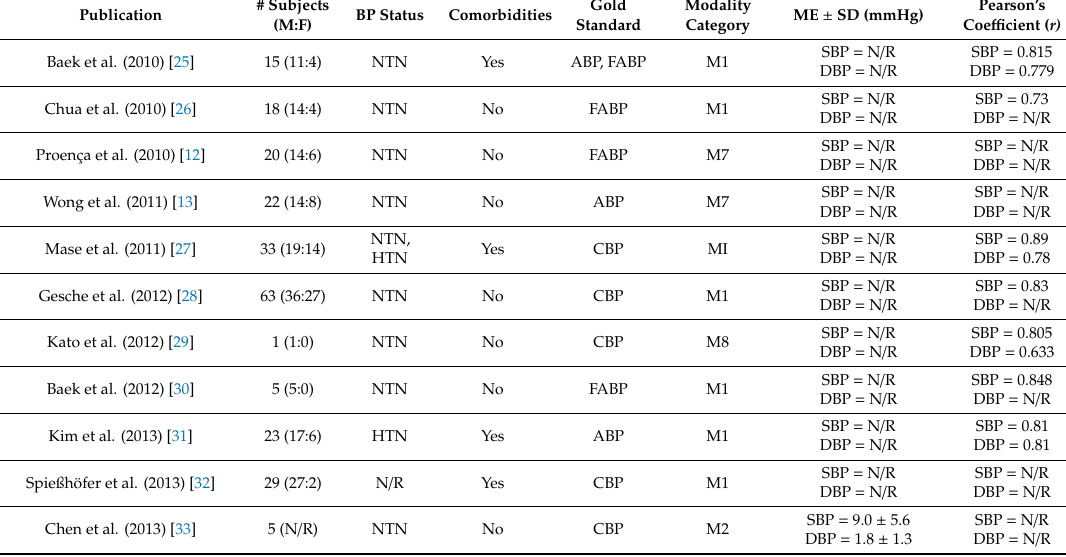
Table1. Summaryfindingsofthe73papersincludedinthisreview. Studiesthatreportedvaluesformultiple study populations have been averaged for simplicity as per our methods and represented in italic. Studies that achieved mean difference and standard deviation for both SBP and DBP within the ANSI / AAMI / ISO 81060–2:2013 (mean difference of test versus reference BP measurements ≤ 5 mmHg with standard deviation ≤ 8 mmHg for systolic and diastolic BP) [24] are represented in bold. M: males, F: females,